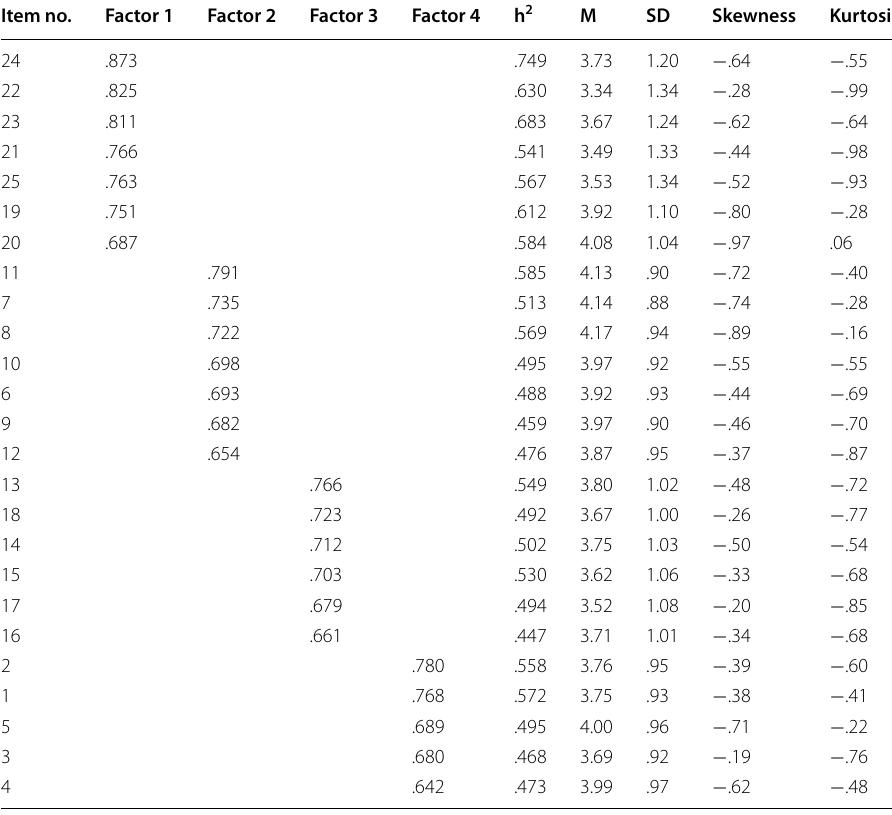
Extraction method: PAF analysis; Rotation method: Promax with Kaiser normalization, four factors extracted